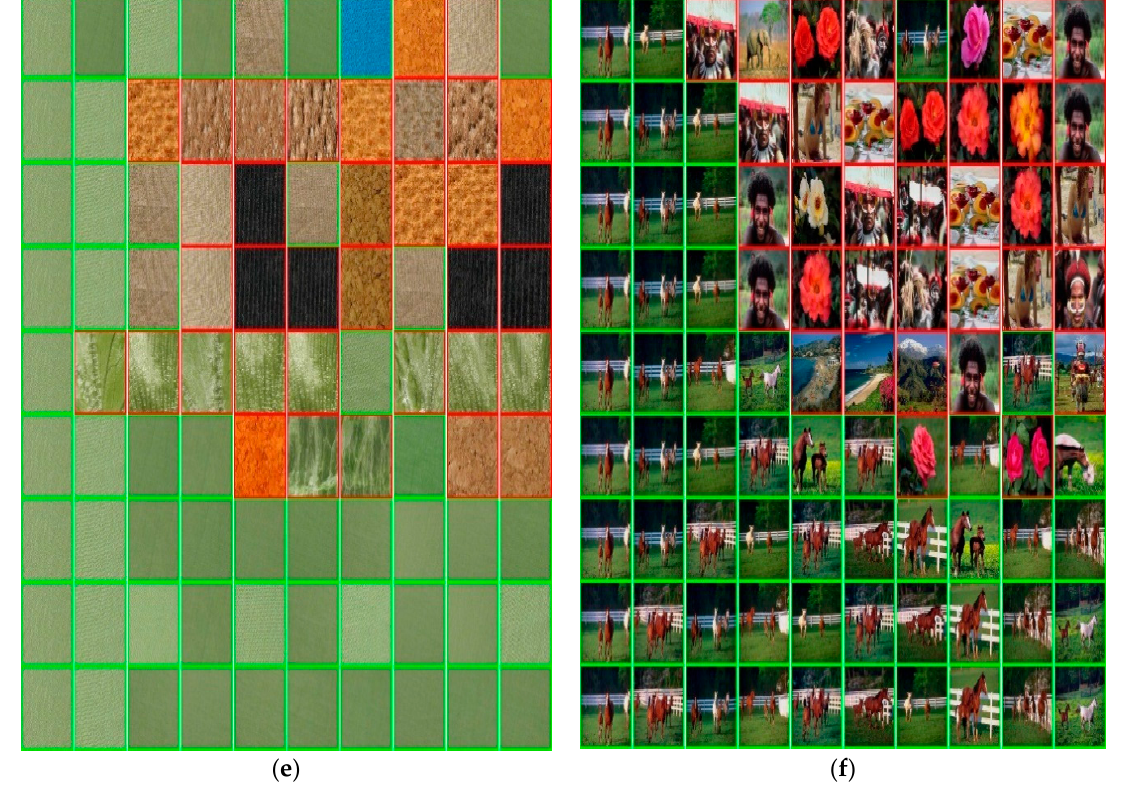
Figure 7. The top-10 returned images using nine methods (the 1st row using OCLBP, the 2nd row using IOCLBP, the 3rd row using maLBP, the 4th row using mdLBP, the 5th row using OC-LBP + CH, the 6th row using LPCP, the 7th row using LTCSP, the 8th row using LTCSP uni , and the 9th row using LTCSP ri ) on: ( a ) Face-95; ( b ) ETHZ; ( c ) ZuBuD; ( d ) VisTex; ( e ) KTH-2a; and ( f ) Corel-1000 respectively.